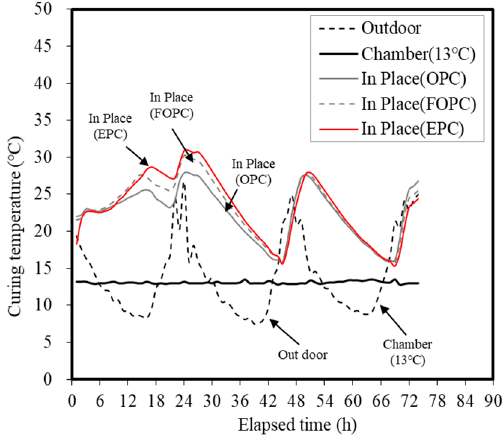
Figure 7. Temperature history of concrete for different curing methods.